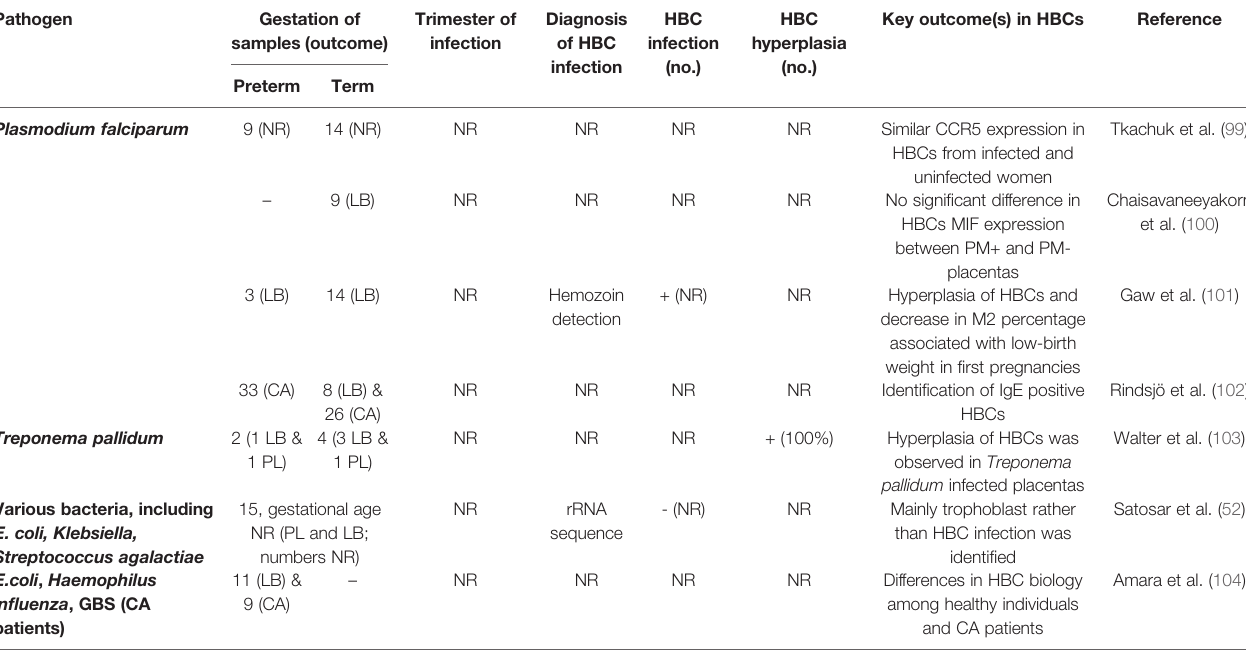
TABLE 3 | Hofbauer cells in observational studies of parasitic and bacterial